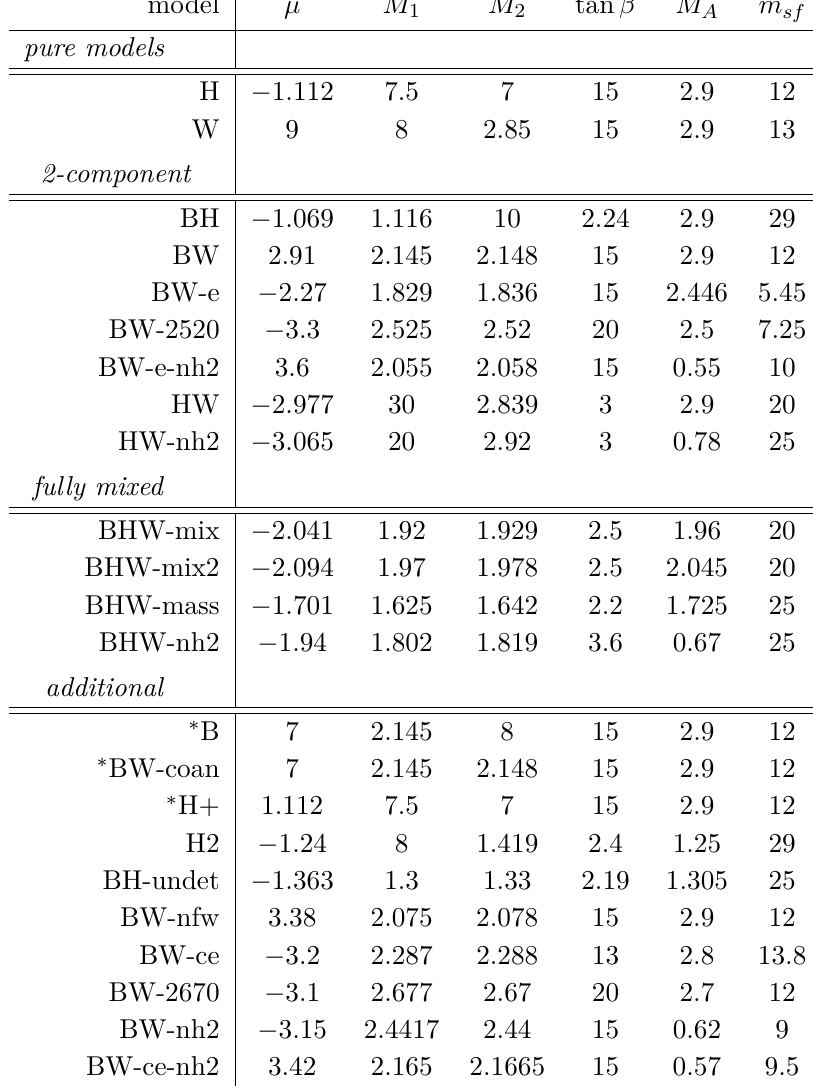
Table 2 . Numerical inputs for used models. Masses are given in TeV. An asterisk ∗ indicates that this model does not produce the observed DM relic